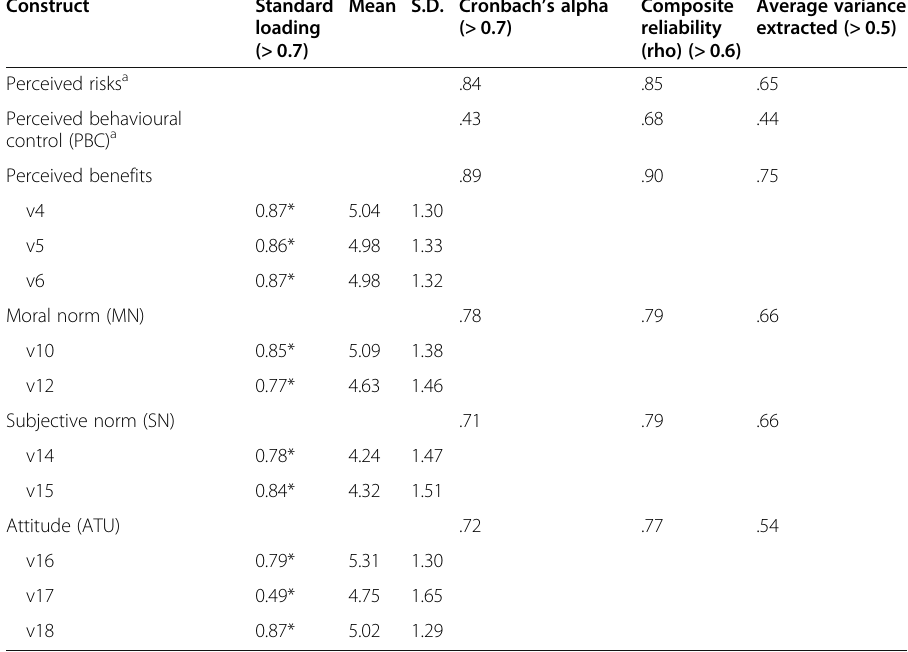
Table 4 Prolonged maternal feeding: Measurement properties of the multi-item constructs ( N = 1852) Construct